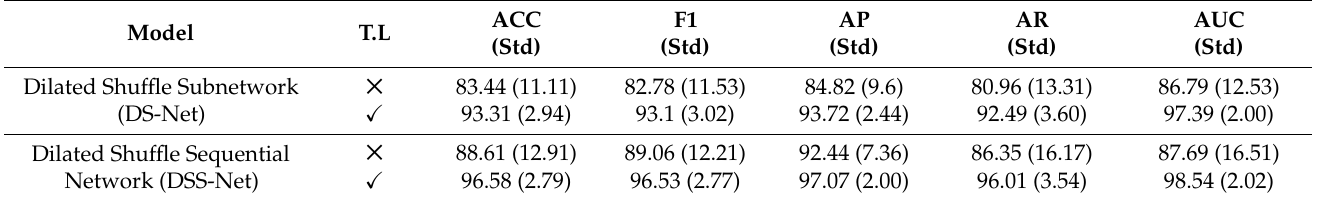
Figure 6. Performance comparison of DSS-Net, DS-Net, and S-Net in terms of confusion matrices. Table 3. Comparative results of the proposed DSS-Net and DS-Net with and without performing transfer learning. (“T.L: Transfer